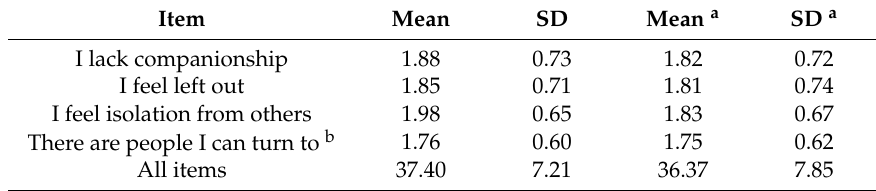
Table 2. Change in R-UCLA Scores in four of the items and for all items before and after the pilot. Item